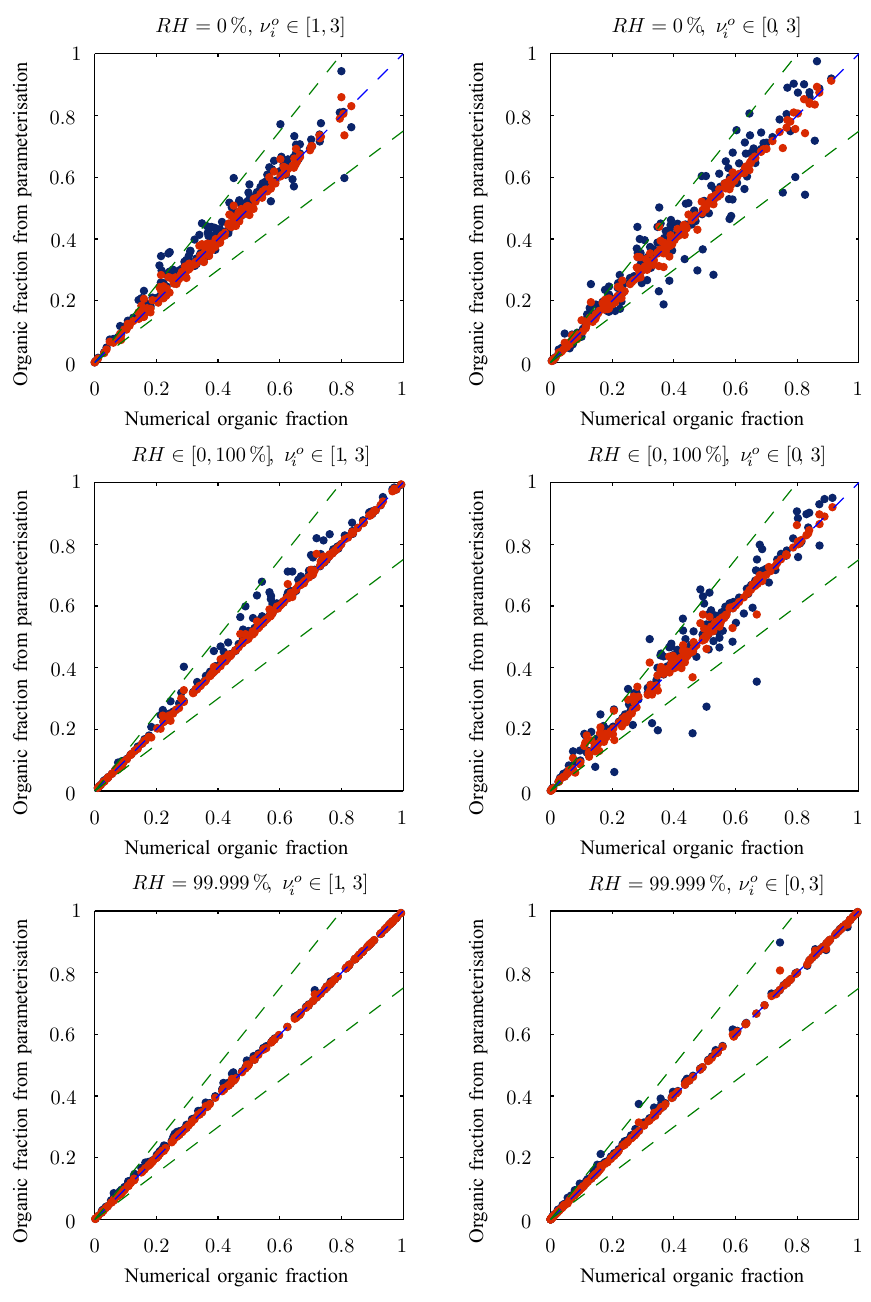
Figure 7. Same as Fig. 5 with the addition of the perturbation solution shown in red. Table 3. Material parameters used in the dynamic model simulations. Total SVOC concentrations are 0.47µgm − 3 , which represents a rescaling of the volatility distribution given in Table 2 by a factor of